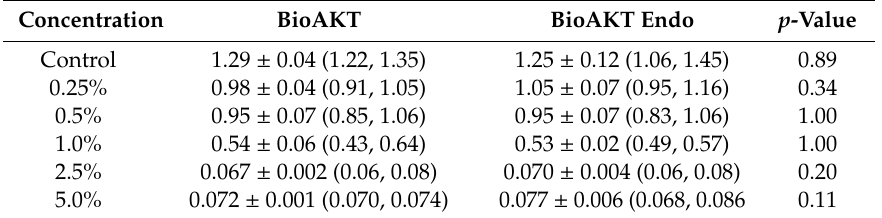
Table 1. Mean values, standard deviations (S.D.), and 95% confidence intervals (CI) of mouse fibroblasts viability (based on M.T.T. assay) for the di ff erent concentrations of the two solutions. p -values of comparisons are also indicated (Mann–Whitney